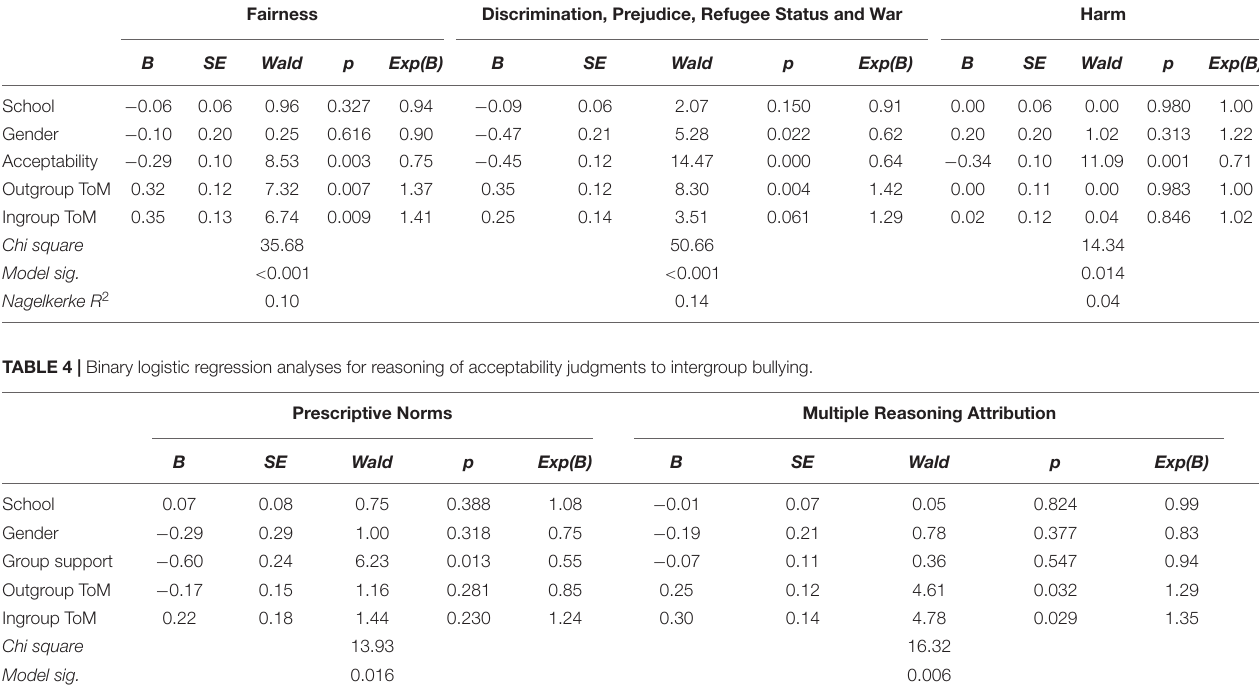
TABLE 3 | Binary logistic regression analyses for reasoning of acceptability judgments to intergroup bullying. Fairness